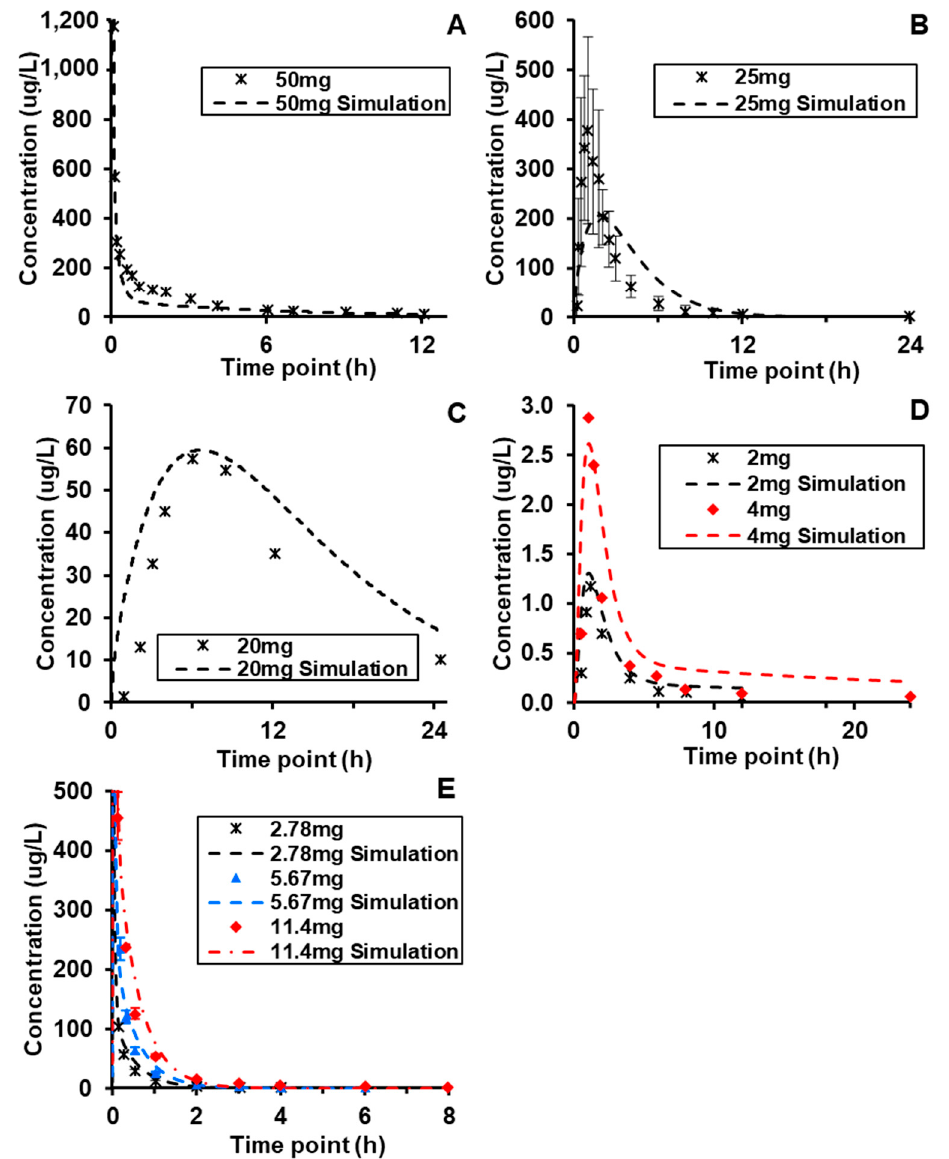
Figure 3. Dose and route-of-administration dependent prediction of compound plasma concentration for ( A ) Verapamil (i.v.), ( B ) Spirapril (p.o.), ( C ) Lisinopril (p.o.), ( D ) Lacidipine (p.o.), and ( E ) Captopril (i.v.). Dashed lines correspond to BIOiSIM simulation outputs. Error bars and individual data points were digitized from the original publications (49,51,55,56,58) and correspond to standard error/standard deviation, as presented in the original work.